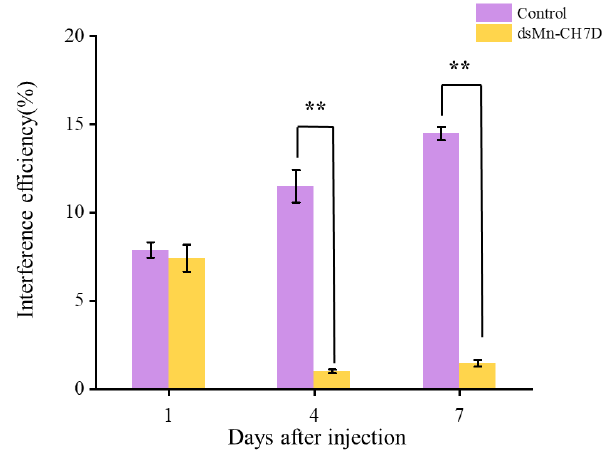
Figure 6. Expression levels of Mn-CH7D in ovaries of Macrobrachium nipponense after injection with Mn-CH7D dsRNA. Data are shown as mean ± SD (n = 6). “**” indicates the significance of the differences ( p < 0.01).